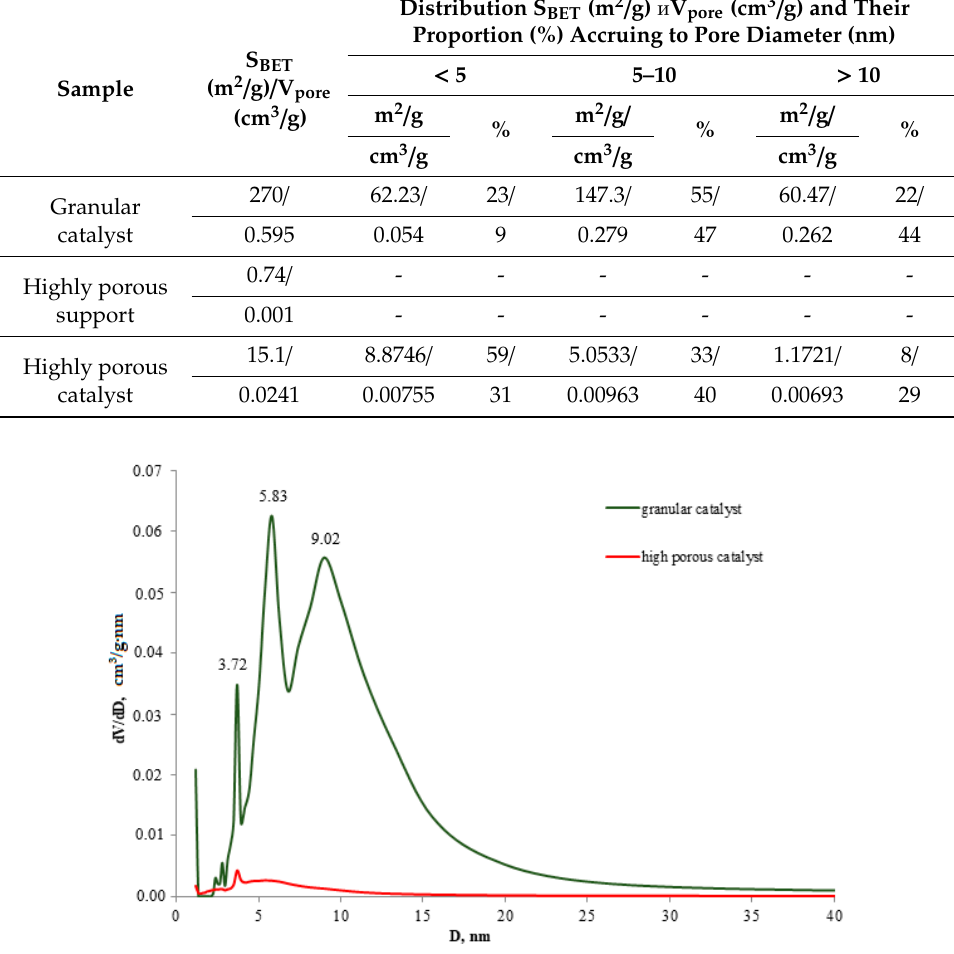
Table 1. Textural characteristics of samples.